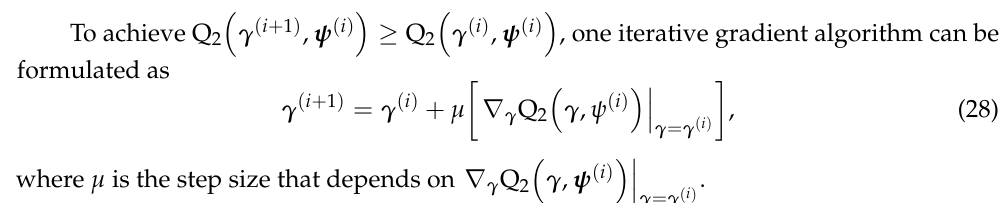
Figure 4. Objective function of echo delay and Doppler